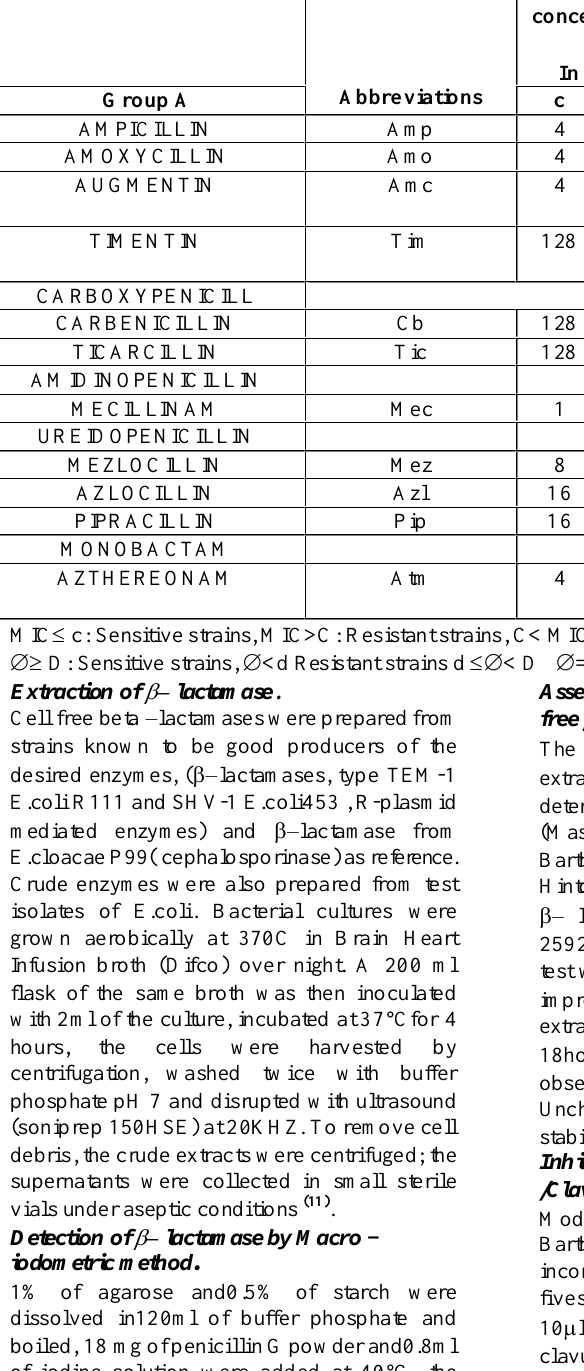
 of * Critical concentration Zone of s Inhibition